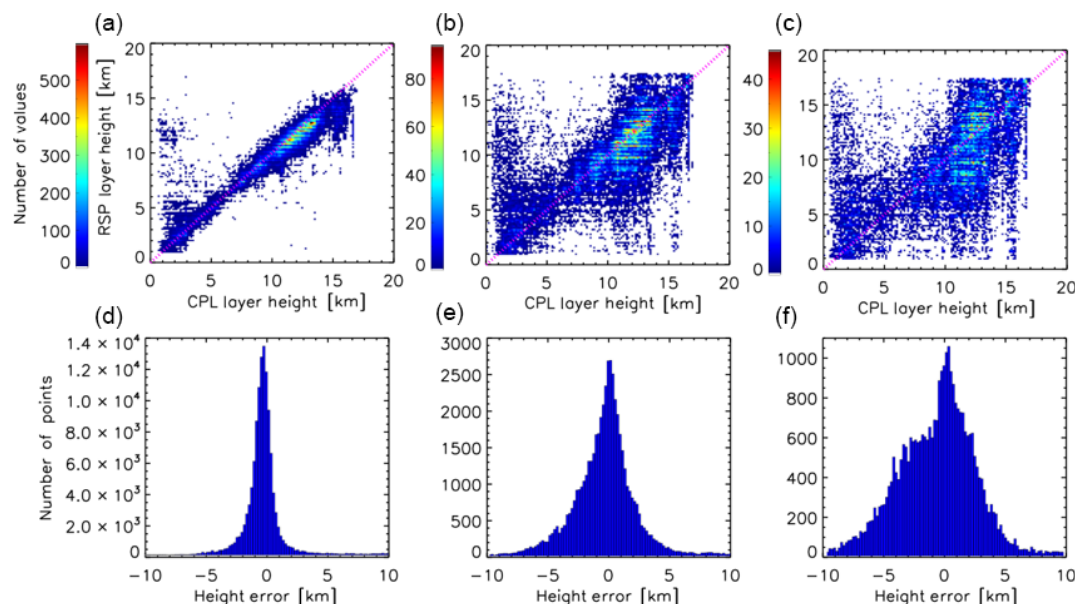
Figure 4. Comparison of CTH retrieved using the RSP 1880nm band and CPL for the primary peak (top left), second peak (top middle) and third peak (top right) with their associated error distributions immediately below each